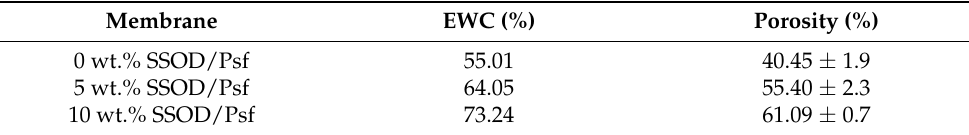
Table 1. Equilibrium water content and porosity of fabricated membranes.